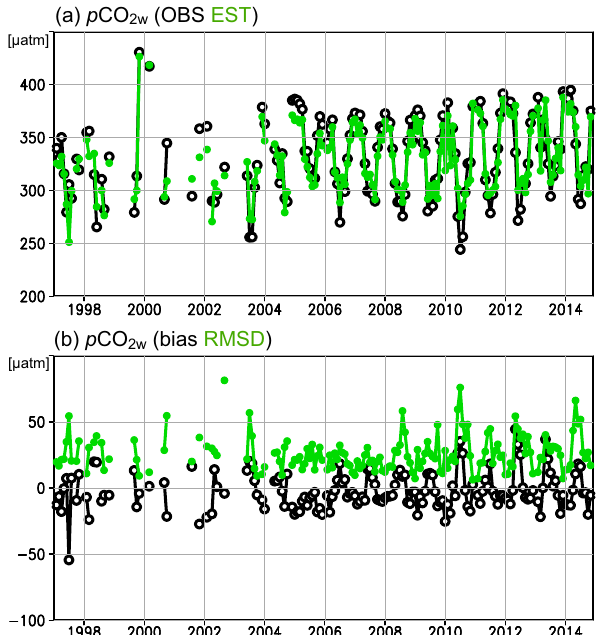
Figure 5. (a) Monthly time series of observed p CO 2w averaged over the entire analysis area (black), and estimated p CO 2w aver- aged over the grid boxes in which observed p CO 2w values were available (green) (µatm). (b) Bias (estimate–observation; black) and RMSD (green) between observed and estimated p CO 2w averaged over the entire analysis area